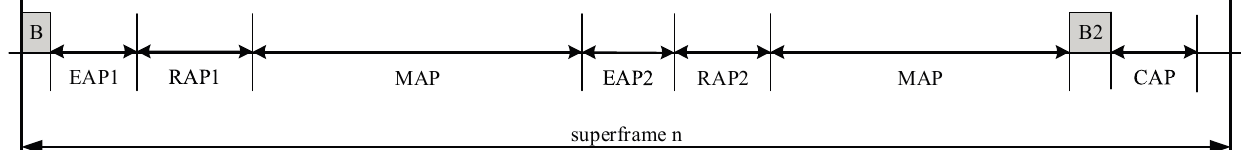
Figure 2. Layout of access phases in a superframe for beacon